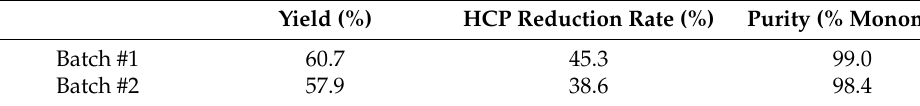
Table 5. Yield, HCP reduction rate and purity results for two verification